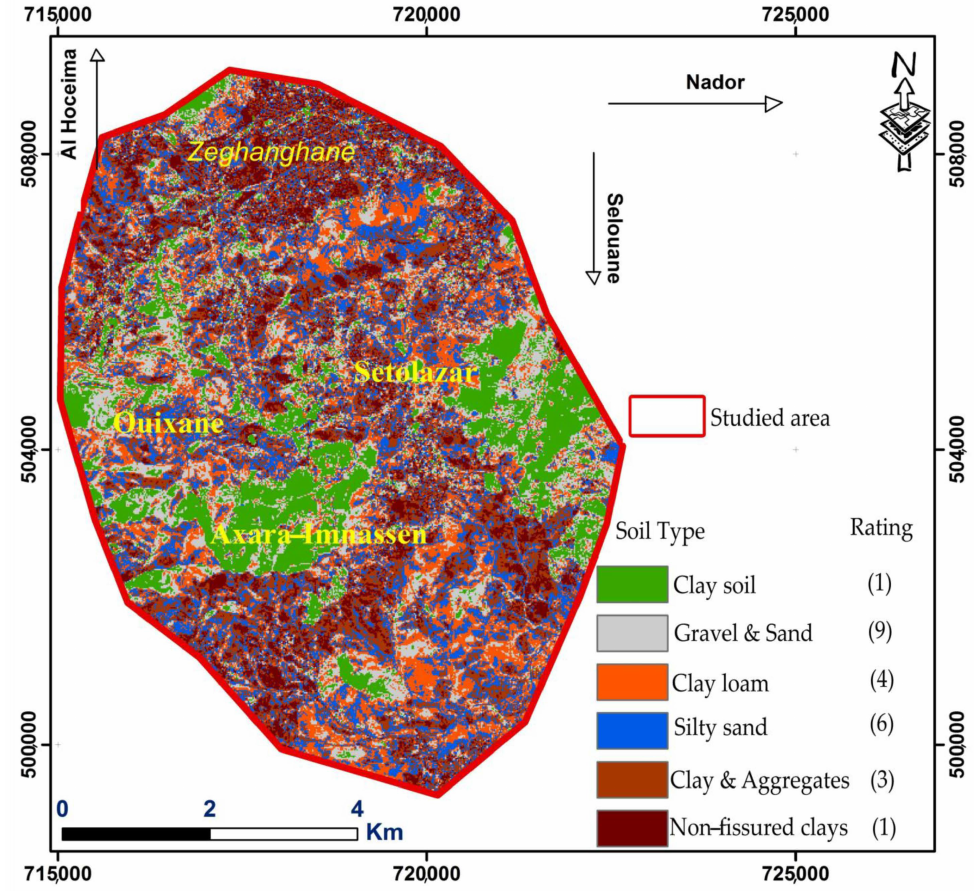
Figure 7. Soil type map and attributed rating